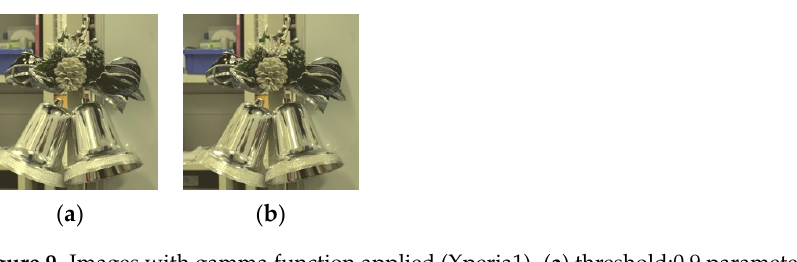
Figure 9. Images with gamma function applied (Xperia1). ( a ) threshold:0.9 parameter: 1.5; ( b ) thresh- old: 0.8 parameter: